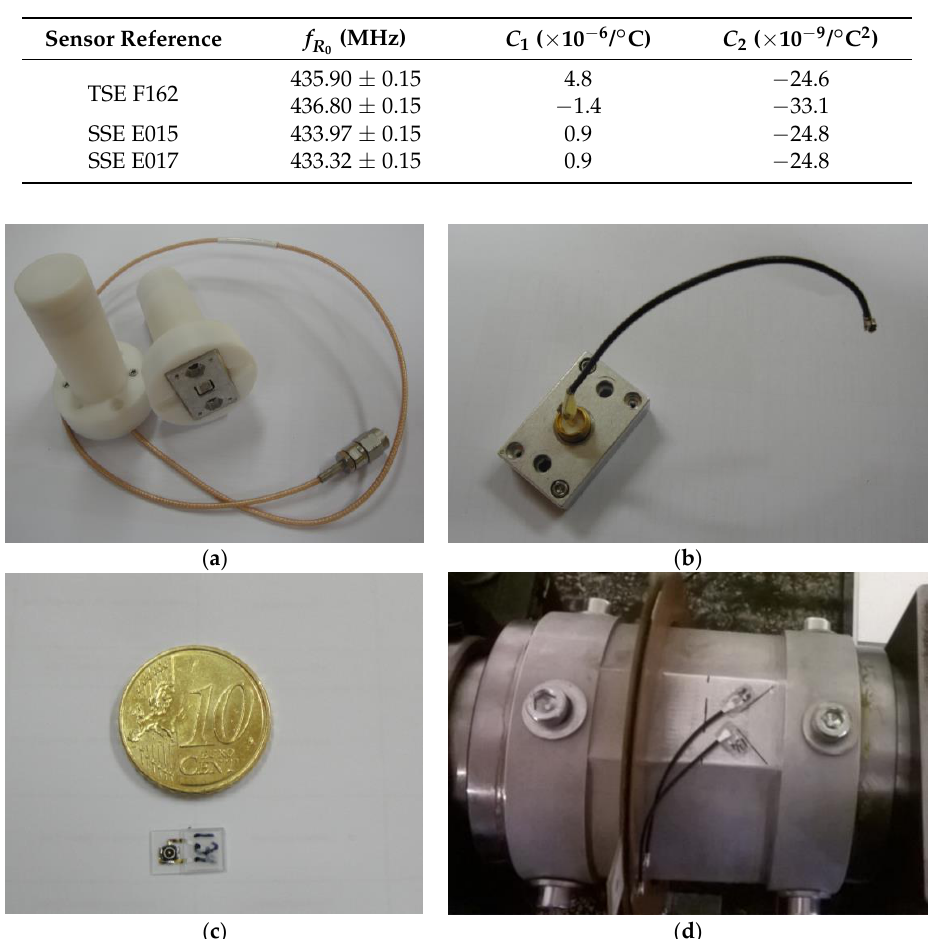
Figure 1. ( a ) COTS commercial off-the-shelf temperature sensor module, composed of sensor chip embedded in an aluminum cage and attached to a radome with the antenna; ( b ) ultra-small surface mount coaxial W.FL cable soldered directly on the SMA (SubMiniature version A) connector connected to the sensor chip embedded in aluminum cage; ( c ) SAW strain gage with W.FL connector clearly visible; ( d ) SAW (surface acoustic wave) strain gages mounted on load cell using half-bridge